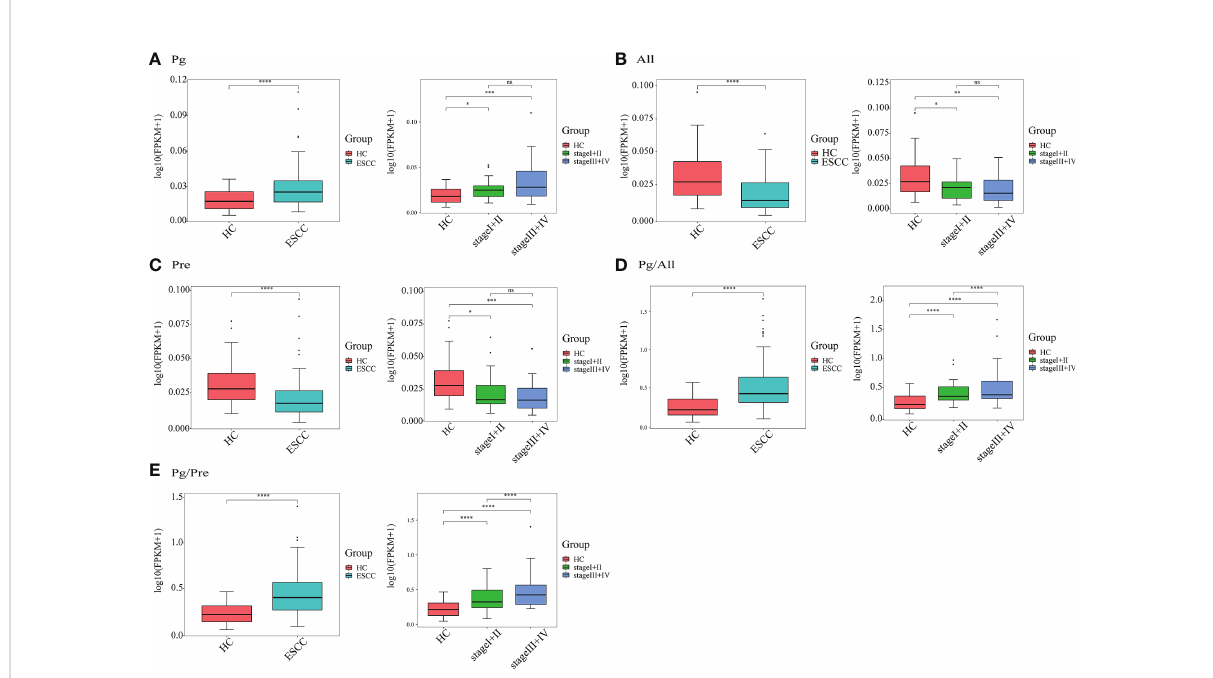
FIGURE 4 Quantitative detection of saliva microbial genera in the ESCC and healthy control (HC) groups. The relative salivary abundances of (A) Porphyromonas ( Pg ), (B) Alloprevotella ( All ), and (C) Prevotella ( Pre ), as well as the ratios of (D) Pg/All and (E) Pg/Pre in all 140 study participants, including 90 ESCC patients and 50 HCs, and in 53 ESCC cases strati fi ed by stage (I+II, n=21; III+IV, n=32) and 50 HCs. * P < 0.01, ** P < 0.001, *** P < 0.0001, **** P < 0.00001 and ns, not signi fi